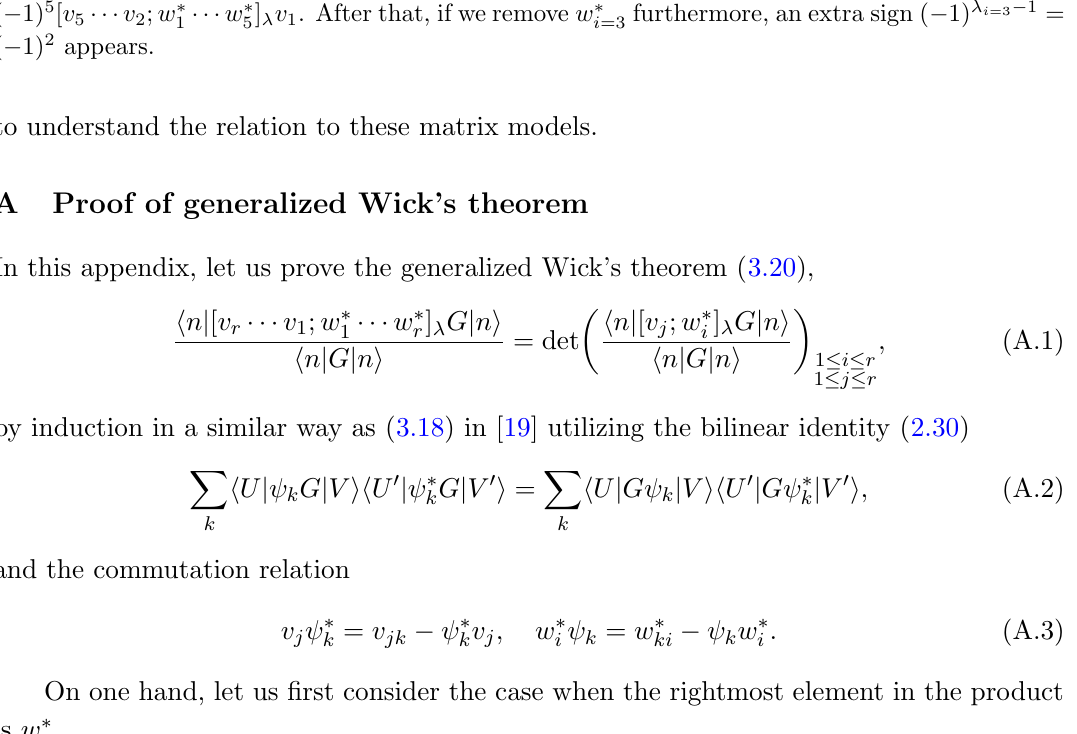
(cid:1) (cid:1) (cid:1) w (cid:3) ] (cid:21) = 1 5 (cid:1) (cid:1) (cid:1) w (cid:3) ] (cid:21) 1 4